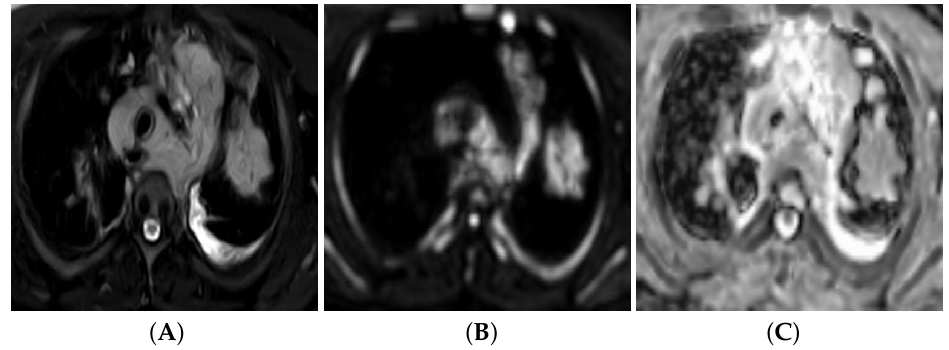
Figure 3. A 38-year-old male with bronchogenic adenocarcinoma. Axial T2 fast spin echo (FSE) with fat suppression ( A ) reveals spiculated left upper lung lobe mass of intermediate to high signal intensity. Diffusion-weighted image, high b-value = 800 mm 2 /s ( B ) and corresponding ADC image ( C ) reveal a mass-constrained diffusion pattern with low ADC value of 1.12 × 10 − 3 mm 2